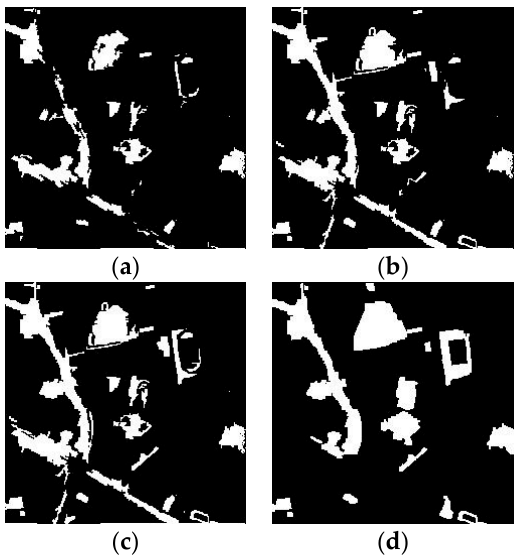
Figure 13. Change detection maps resulting from: ( a ) Otsu’s thresholding method, ( b ) threshold selection by clustering gray levels of boundary, and ( c ) k -means clustering ( k = 2), compared with ( d ) the reference image, with L2 as the basis image in the second study area (scale = 50).